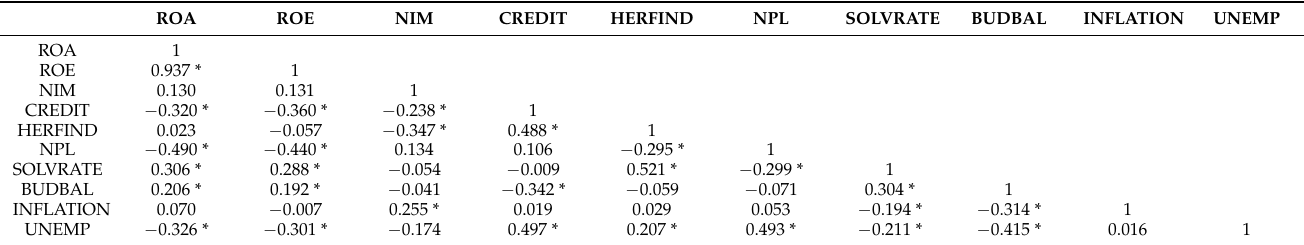
Table 3. Pearson correlation coefficients for variables included in the study, full sample